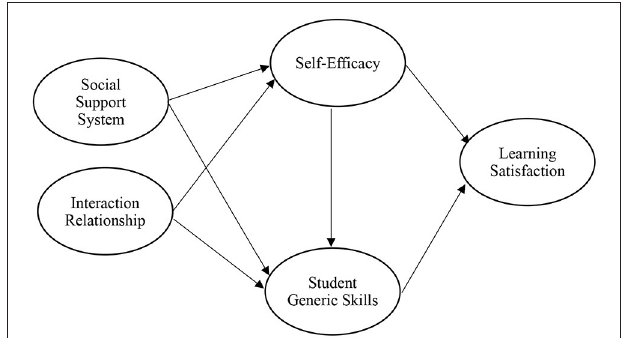
FIGURE 1 | Research